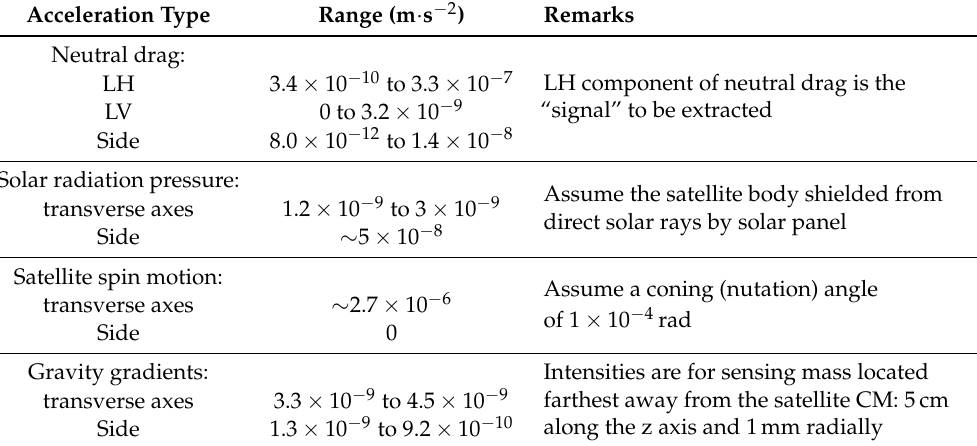
Table 1. Expected amplitudes of accelerations acting on METRIC for a 450 × 1200 km Sun-synchronous orbit, with an altitude range of 471to 1221km above the reference ellipsoid.